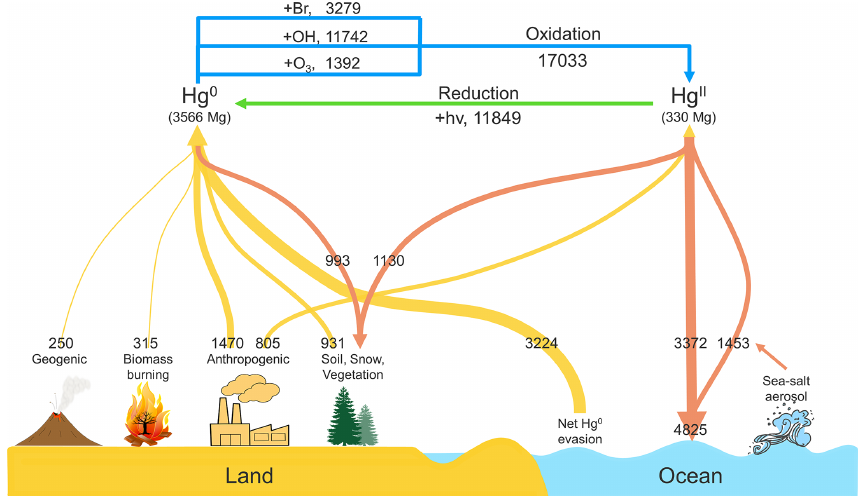
Figure 1. Global budget of atmospheric mercury in CAM6-Chem/Hg. Only the reaction rates of three major oxidants are shown. Fluxes in Mga − 1 . The thickness of the arrows represents the relative